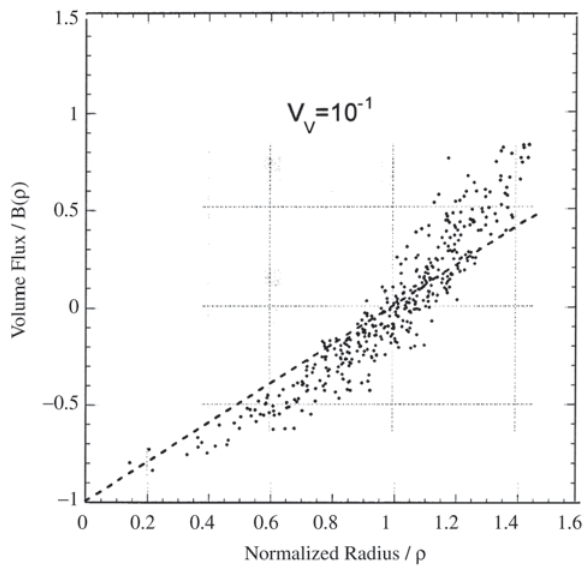
Figure 8. Volume flux per steradian, B( ρ ), versus scaled particle radius, ρ . Data are simulated from the multiparticle diffusion model for a microstructure with a dispersoid volume fraction V Locale noise, except perhaps for the smallest particles exhibits strong stochastic behavior. That is, particles, particularly those close to the average size within the simulated microstructure, act unpre- dictably by occasionally growing or dissolving rapidly. Were the average size particles to act deterministically, they would hardly grow or shrink at all. The fluctuations at this volume fraction also exhibit non-linear departures from the LSW prediction (dashed